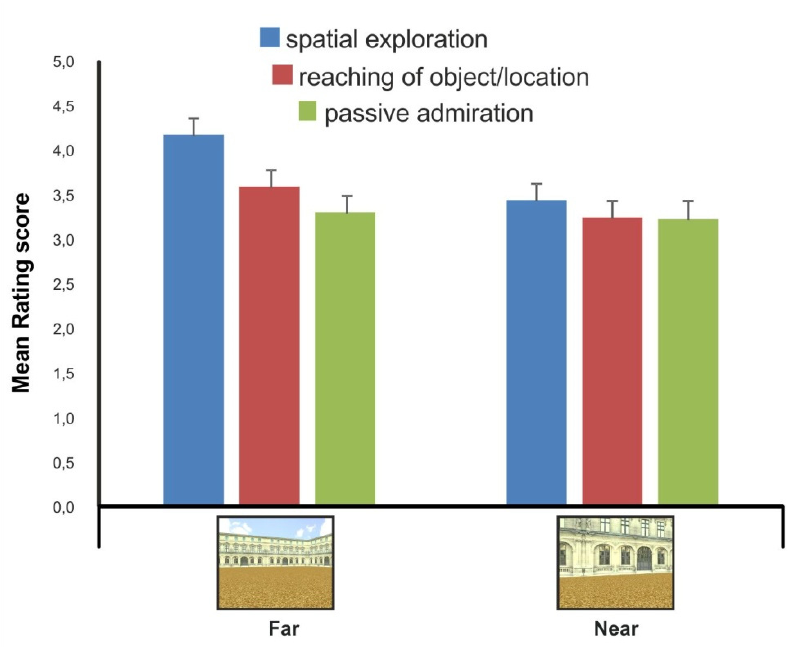
Figure 6. Stimulus rating (far/panoramic vs. near/front views of the environmental layout) ac- cording to the three conditions of viewer–environment interaction (spatial exploration, reaching of object/location, passive admiration). Error bars represent the standard error of the